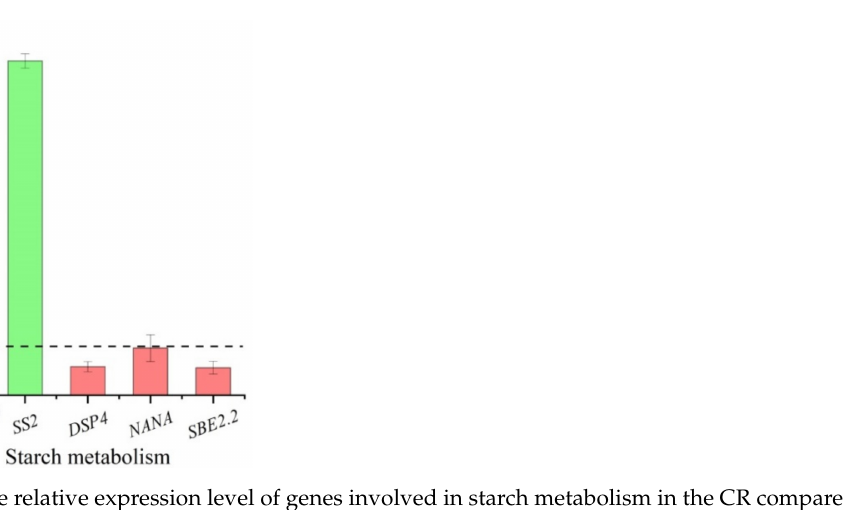
Figure 9. The relative expression level of genes involved in starch metabolism in the CR compared with CS, as determined by qRT-PCR.